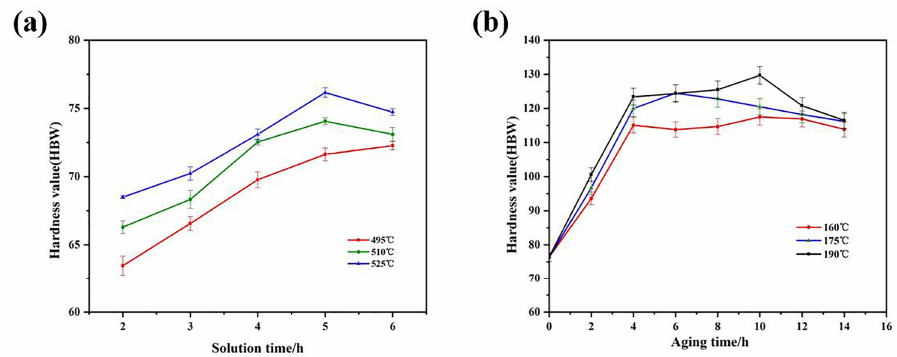
Figure 8. As-extruded Al-9.5Si-1.5Cu-0.8Mn-0.6Mg alloy: ( a ) solution-hardness curve; ( b ) aging- hardness curve.